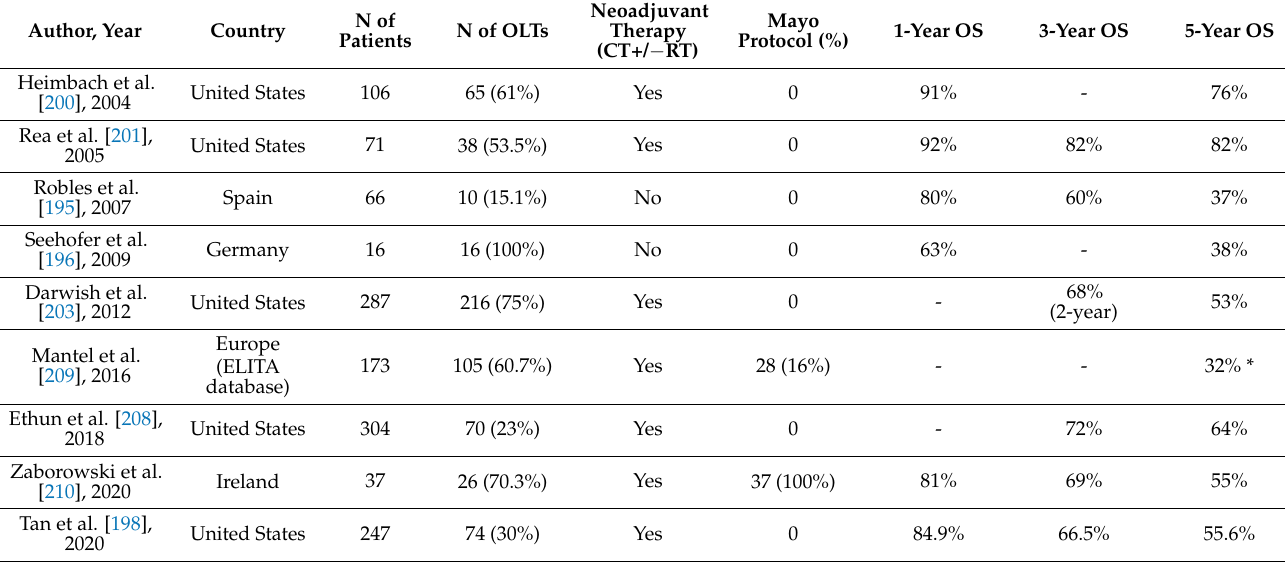
Table 6. Results of liver transplantation for